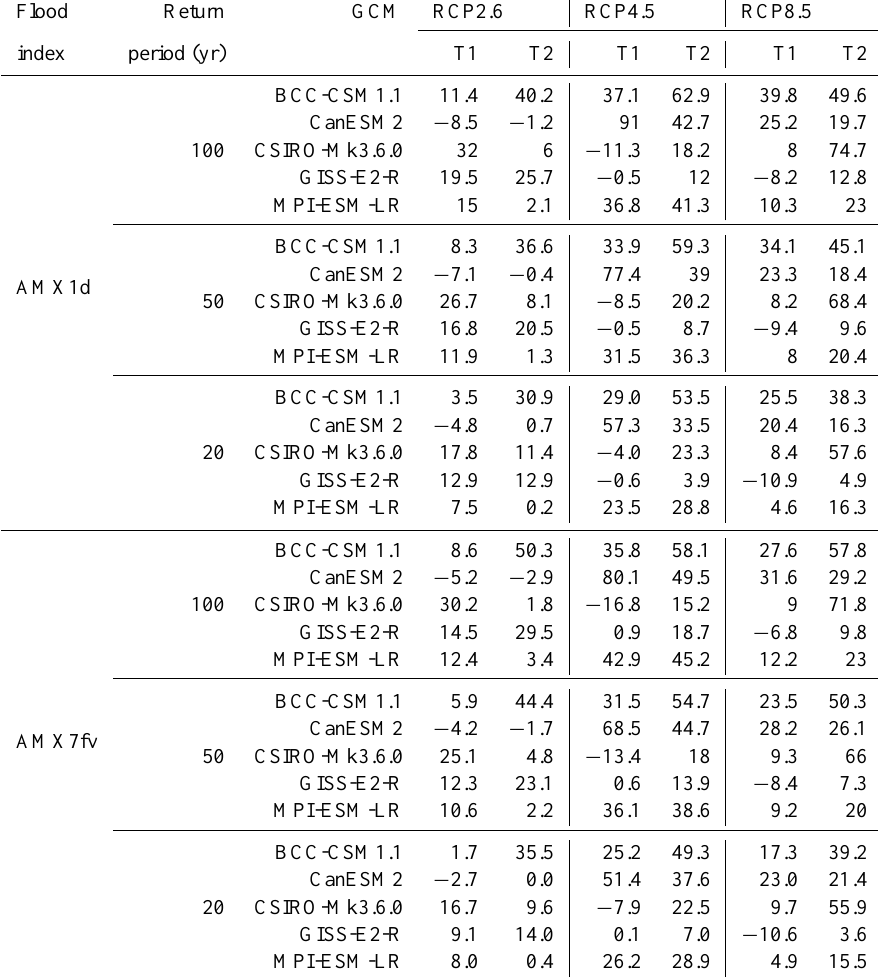
Table 3. Percentage changes (%) in AMX1d and AMX7fv for different return periods under different scenarios (relative to the baseline period